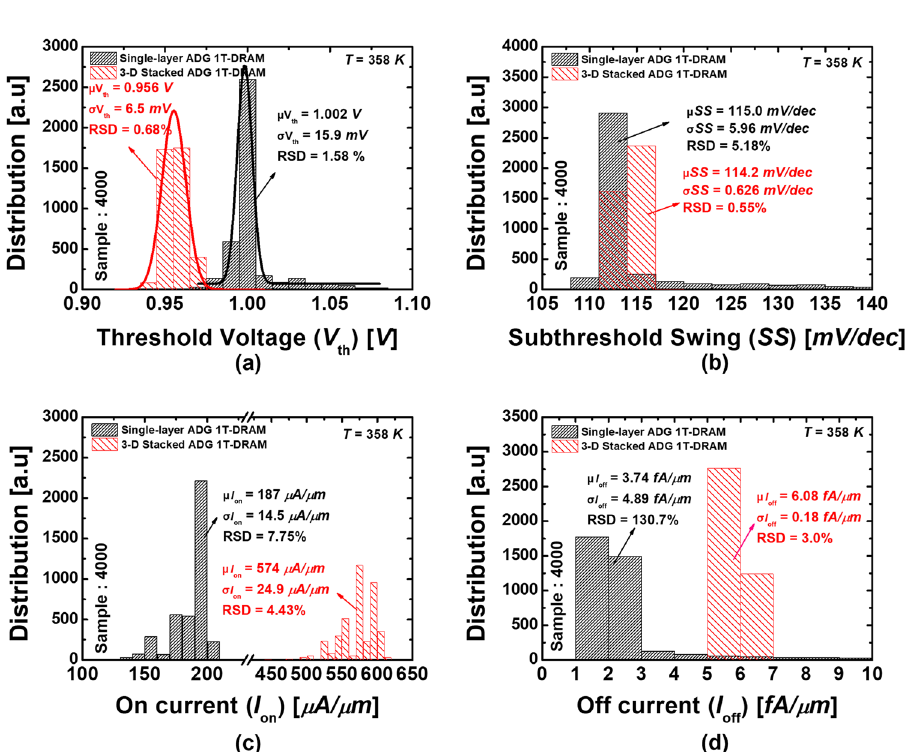
Figure 5. Histograms of ( a ) the V th s (b) the SS s ( c ) the I on s and ( d ) the I off s obtained from the proposed single- layer 1 T-DRAMs’ and 3-D stacked 1 T-DRAMs’ 4000 samples with the proposed GB